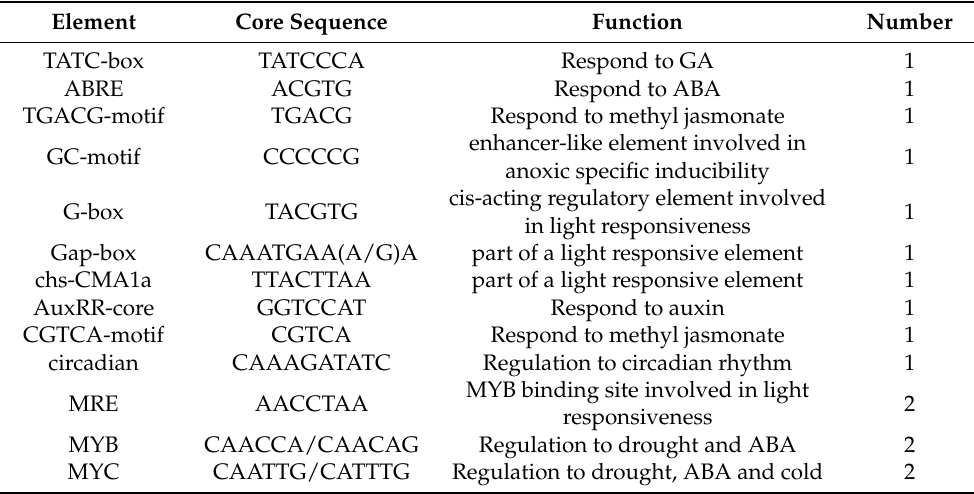
Table 1. Prediction of major stress-related cis-elements in PtCP5